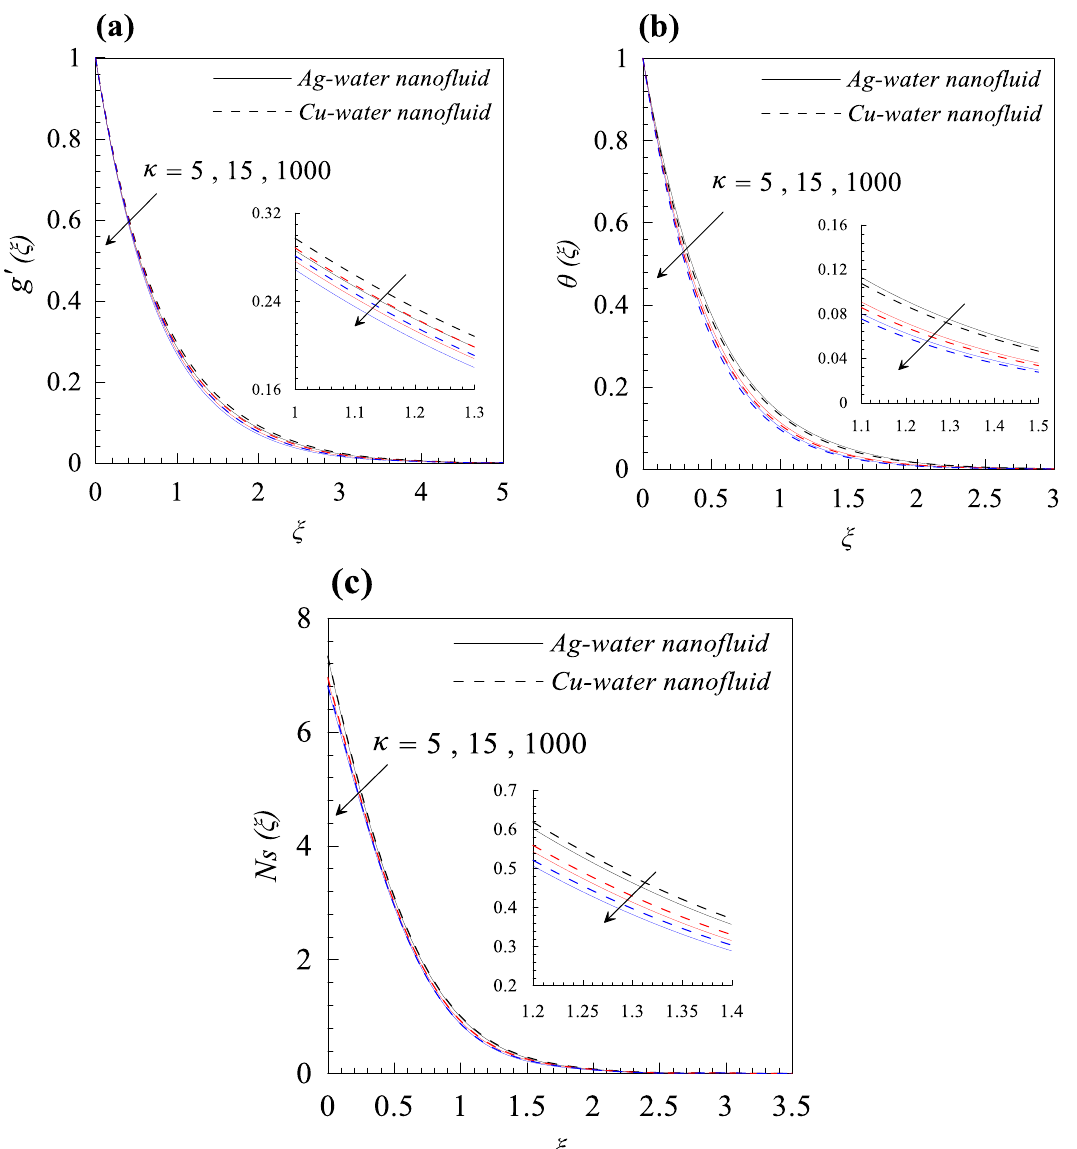
( ) g  , ( b ) temperature distribution